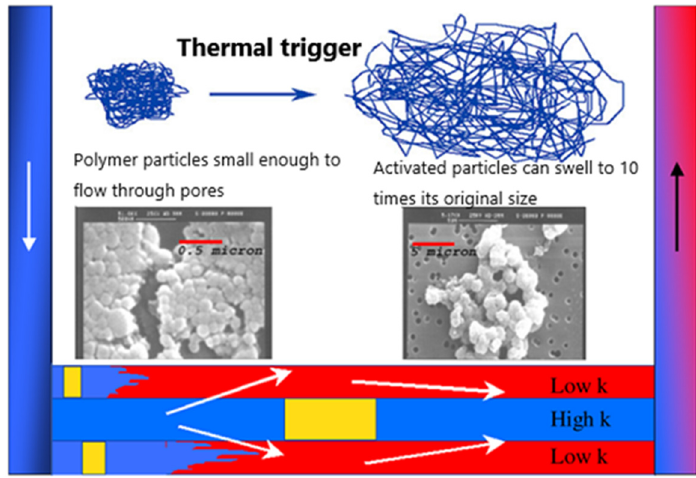
Figure 20. Flooding mechanism of Brightwater ® . (Reprinted/adapted with permission from Ref. [99], 2010, Roussennac and Toschi.).